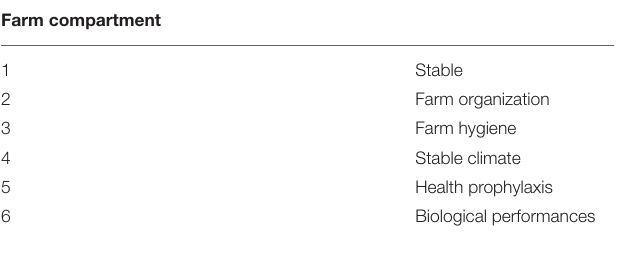
TABLE 2 | Farm compartments comprised by the “intensive farm questionnaire” for the production systems breeding sow keepers, piglet breeders, and fattening pig keepers.